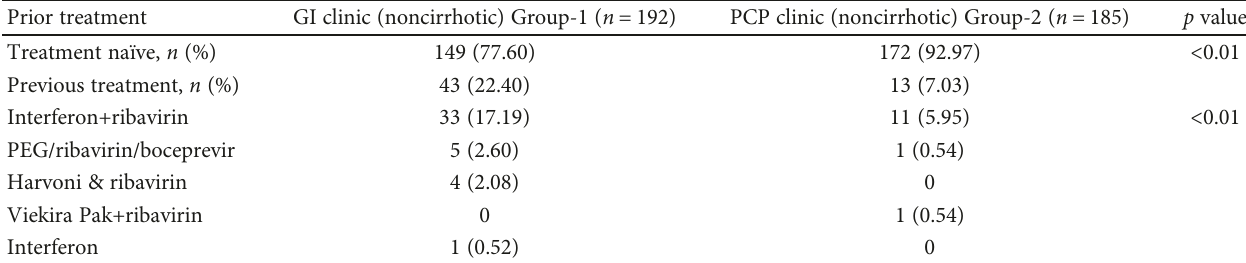
Table 3: Prior hepatitis C treatment regimens for patients treated in GI vs. PCP clinic.